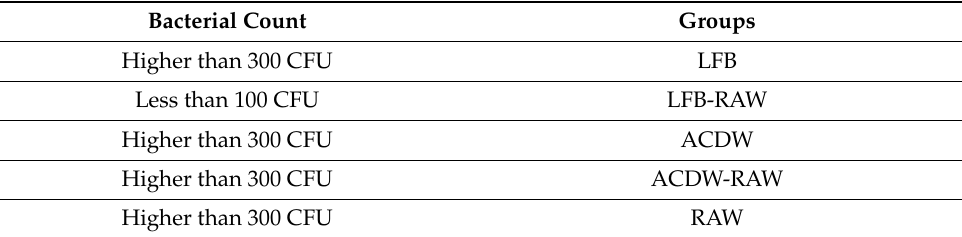
Table 4. Bacterial count as a result of treatment of real aquaculture wastewater using LFB and ACDW.